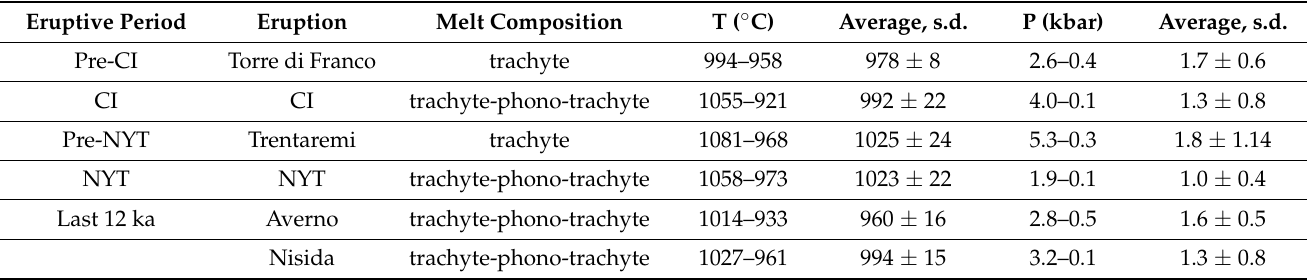
Table 4. Temperature and pressure output obtained from the Masotta et al. [30] geothermobarometers applied to clinopyroxene-melt couples whose equilibrium has been verified with equilibrium test